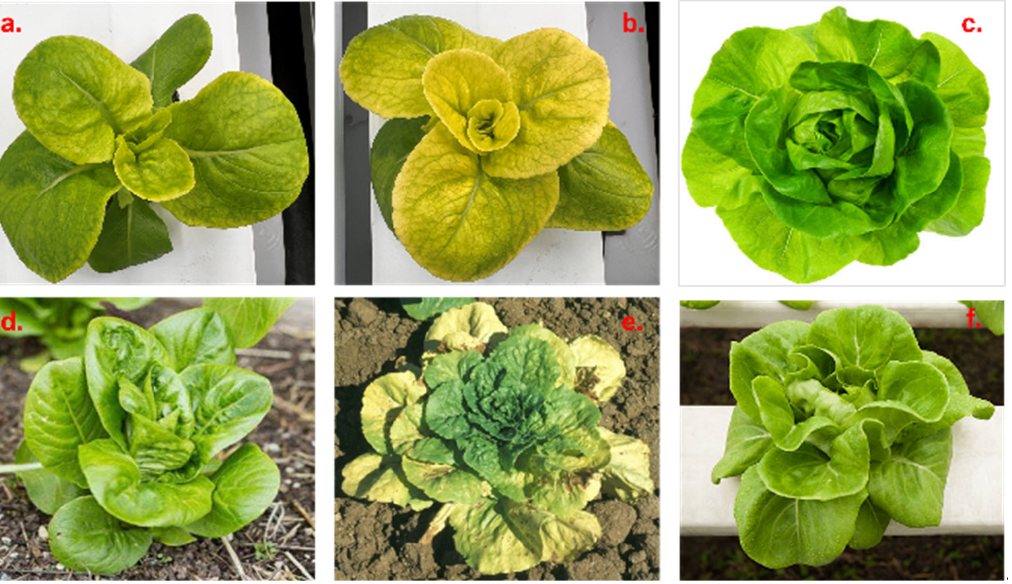
Figure 2. Image dataset: ( a , b ) acquired from aquaponics facility, and ( c – f ) are downloaded from ecosia.org.